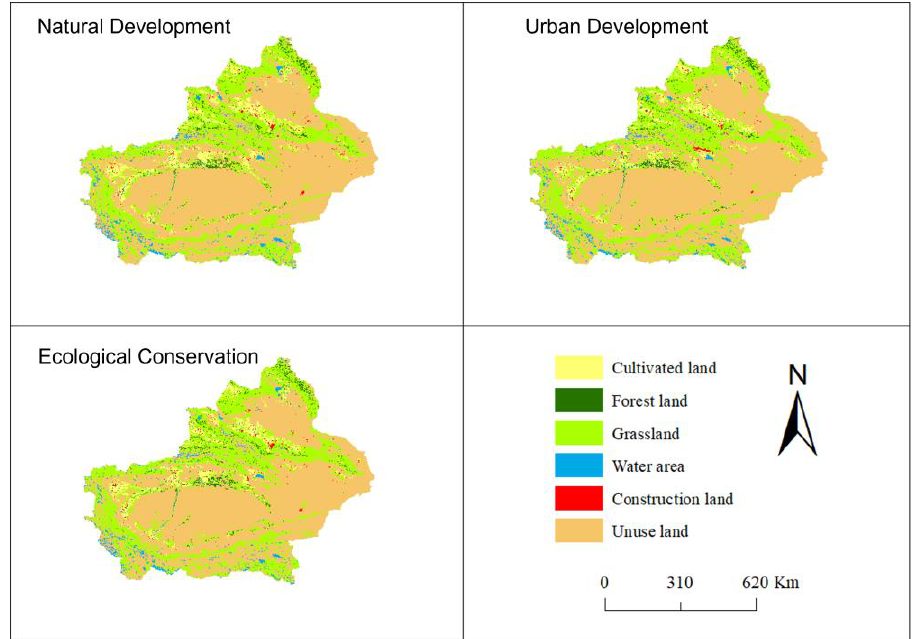
Figure 4. Predicted land use changes in Xinjiang in 2030 under different development scenarios.